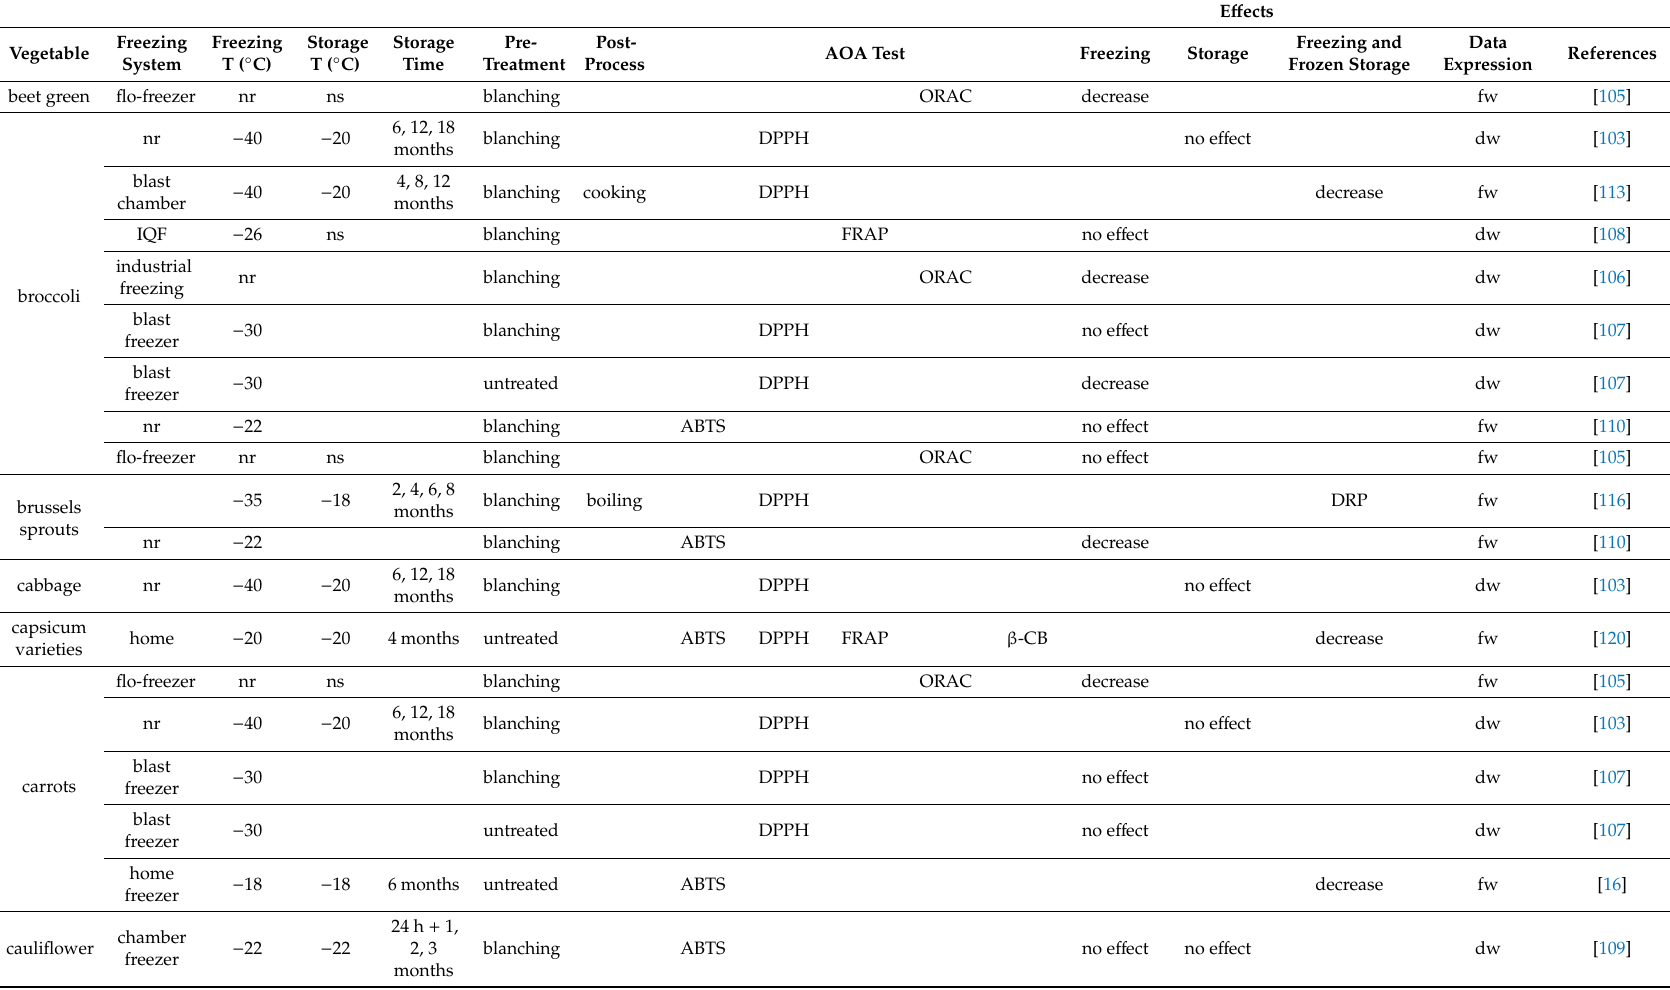
Table 1. Single and combined e ff ect of freezing and frozen storage on the antioxidant activity of